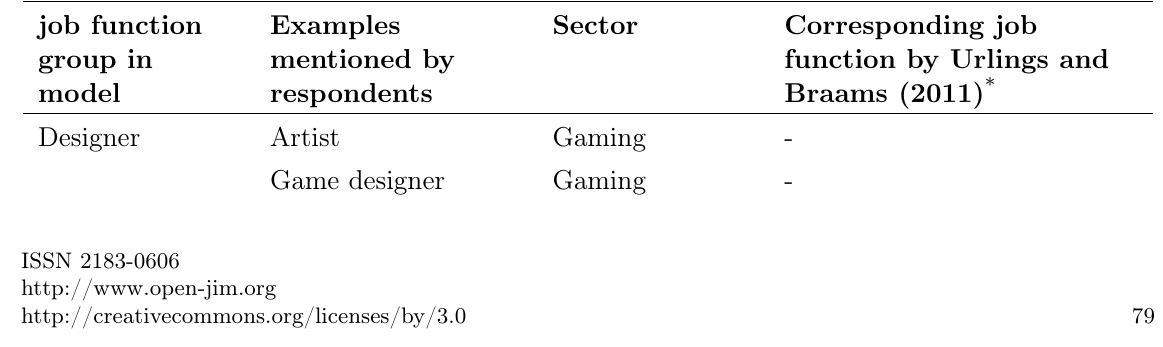
Table 3. job functions mentioned by respondents and their corresponding job function group in the